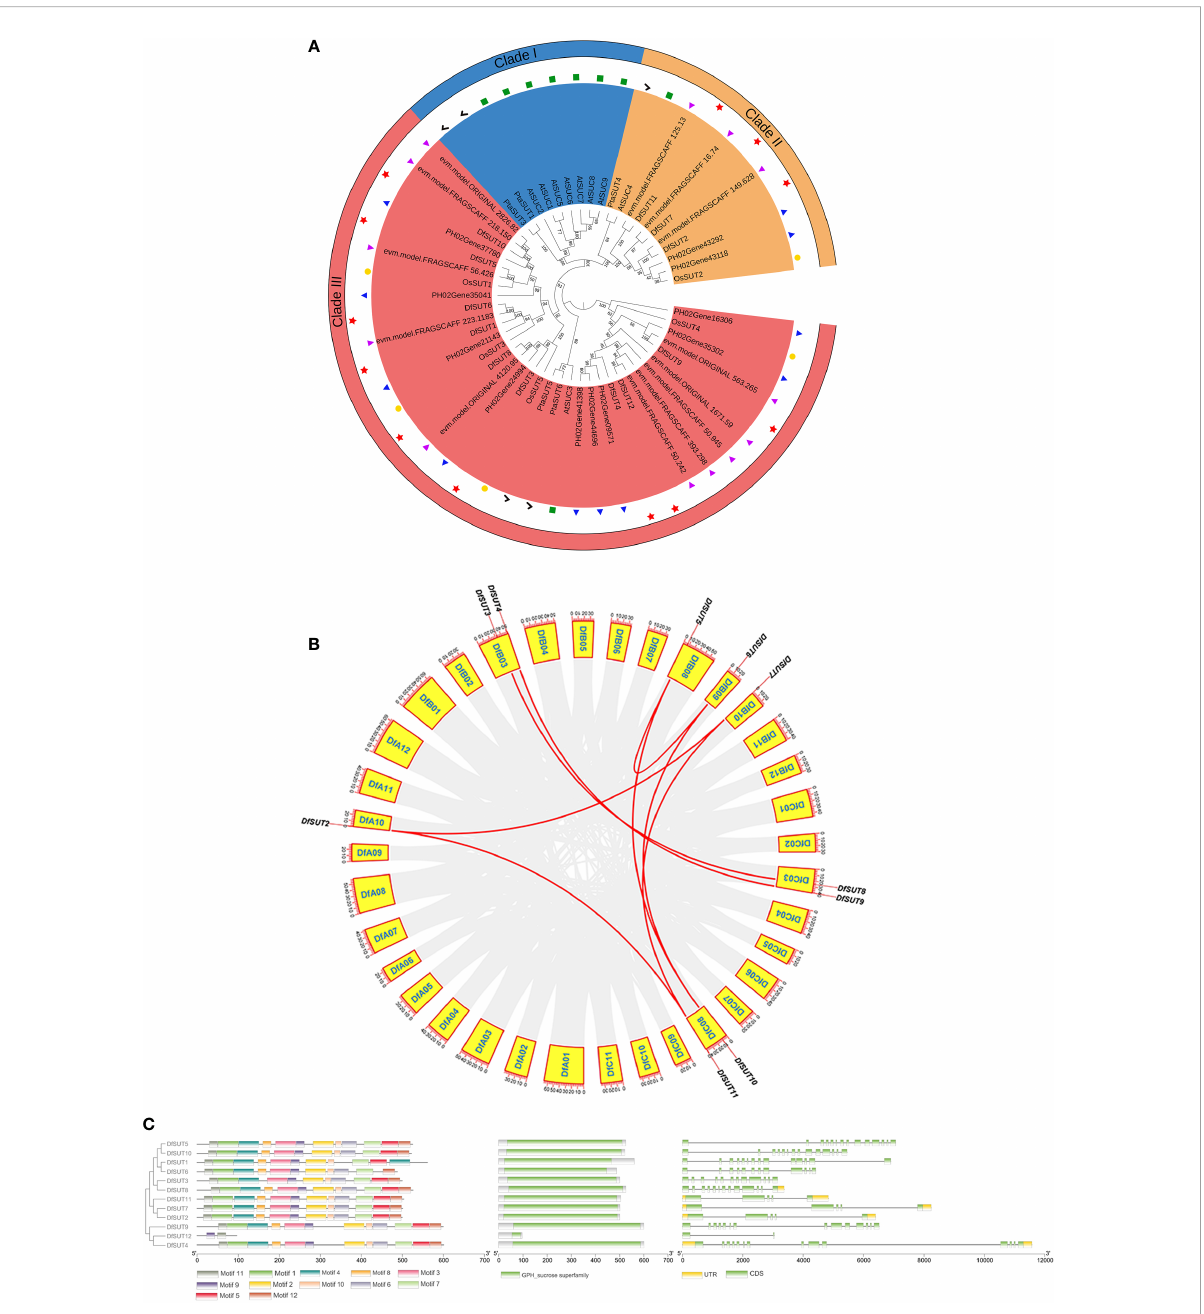
FIGURE 1 Analysis of the phylogenetic evolutionary, chromosomal localization and gene structure of the SUT family in D. farinosus. (A) Phylogenetic tree of the SUT family in D. farinosus. Based on the amino acid sequences of D. farinosus , Phyllostachys edulis , D. lati fl orus munro , Arabidopsis , rice, and Populus L., phylogenetic trees were generated by the neighbor joining method using MEGA 7.0.21. The SUT members are divided into three branches: clades I, II, and III. The species are labeled with different colors: Df, D. farinosus (red); Phyllostachys edulis (blue); D. lati fl orus munro (purple); At, Arabidopsis (green); Os, rice (yellow); Pta, Populus L. (black). (B) Chromosomal localization and gene duplication analysis of DfSUT genes in the genome of D. farinosus. The DfSUT genes are localized on different chromosomes. Chromosome numbers are indicated in the yellow box. The numbers on the chromosome boxes represent the sequence length in megabases. Gene pairs with sibling relationships are connected by a red line. (C) Conserved motif and gene structure analysis of the SUT family in D. farinosus . The three maps of conserved motif analysis, conserved structural domains, and exon/intron structure of SUT genes were merged in the order of phylogenetic tree by the Gene Structure View online software analysis of TBtools